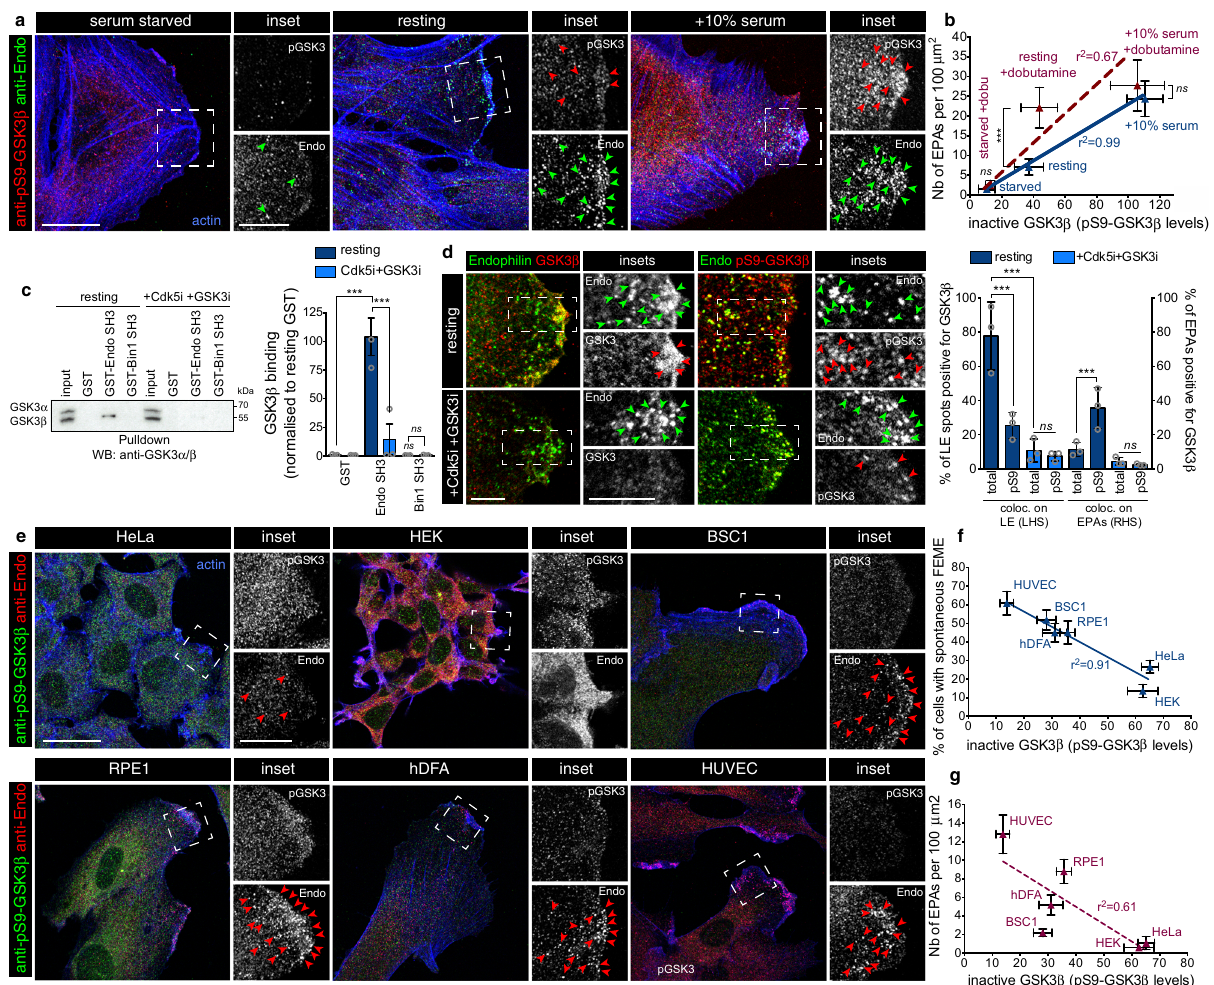
Fig. 2 Endophilin recruits GSK3 β for local regulation of FEME. a Confocal images showing levels of phosphorylated Ser9 GSK3 β (pS9-GSK3 β ) inactive kinase, and colocalization with Endophilin in cells starved of serum for 1 h (serum starved), grown in 10% serum medium (resting) or stimulated with additional serum for 10 min ( + 10% serum). Arrowheads point at cytoplasmic Endophilin-positive assemblies (EPAs), FEME carriers. Scale bar, 20 μ m (main) and 10 μ m (inset). b Correlation between the number of EPAs and pS9-GSK3 β levels (single cell measurements) in cells that were starved of serum for 1 h (starved), grown in 10% serum medium (resting) or stimulated with additional serum for 10min ( + 10% serum), followed by the addition of 10 μ M dobutamine for 4 min (red data points) or not (blue data points). Plots show the mean ± SEM from fi ve cells per condition from three independent biological experiments. Linear regression fi t is indicated as r 2 values. Statistical analysis was performed by one-way ANOVA. ns non signi fi cant, *** P < 0.001. c Pull-down experiments using beads with GST-SH3 domains of Endophilin A2 or Bin1, in resting cells or cells treated with 5 μ M Dinaciclib (Cdk5i) and CHIR- 99021 (GSK3i) for 10min. GST beads were used as negative control. Bound GSK3 β was detected using an antibody that detects both GSK3 α and GSK3 β . Histograms show the mean ± SEM of GSK3 β binding, normalized to resting GST levels from three independent biological experiments. Statistical analysis was performed by one-way ANOVA. ns non signi fi cant, *** P < 0.001. d Colocalization of total and phosphorylated Ser9 GSK3 β and Endophilin in cells treated with 5 μ M Cdk5 and GSK3 inhibitors for 10min, or not (resting). Arrowheads point at Endophilin spots and FEME carriers. Scale bars, 5 μ m. Histograms show the mean ± SEM of Endophilin spots at the leading edge of cells (spots within 1 μ m of cell edges, LHS: left hand side) and on EPAs (RHS: right hand side) positive for total or pS9-GSK3 β . n = 50 spots or EPAs per condition, from three independent biological experiments. Statistical analysis was performed by one-way ANOVA. ns non signi fi cant, *** P < 0.001. e Confocal images showing levels of pS9-GSK3 β and colocalization with Endophilin in resting HeLa, HEK, BSC1, RPE1, hDFA, or HUVEC grown in their respective full serum media. Arrowheads point at FEME carriers. Scale bar, 20 μ m (main) and 10 μ m (inset). f Correlation between the percentage of cells displaying active FEME and their pS9-GSK3 β levels (single cell measurements) in the indicated resting cell types. Plots show the mean ± SEM from fi ve cells per condition from three independent biological experiments. Linear regression fi t is indicated as r 2 value. g Correlation between the number of EPAs and pS9-GSK3 β levels (single cell measurements) in the indicated resting cell types. Plots show the mean ± SEM from fi ve cells per condition from three independent biological experiments. Linear regression fi t is indicated as r 2 value.